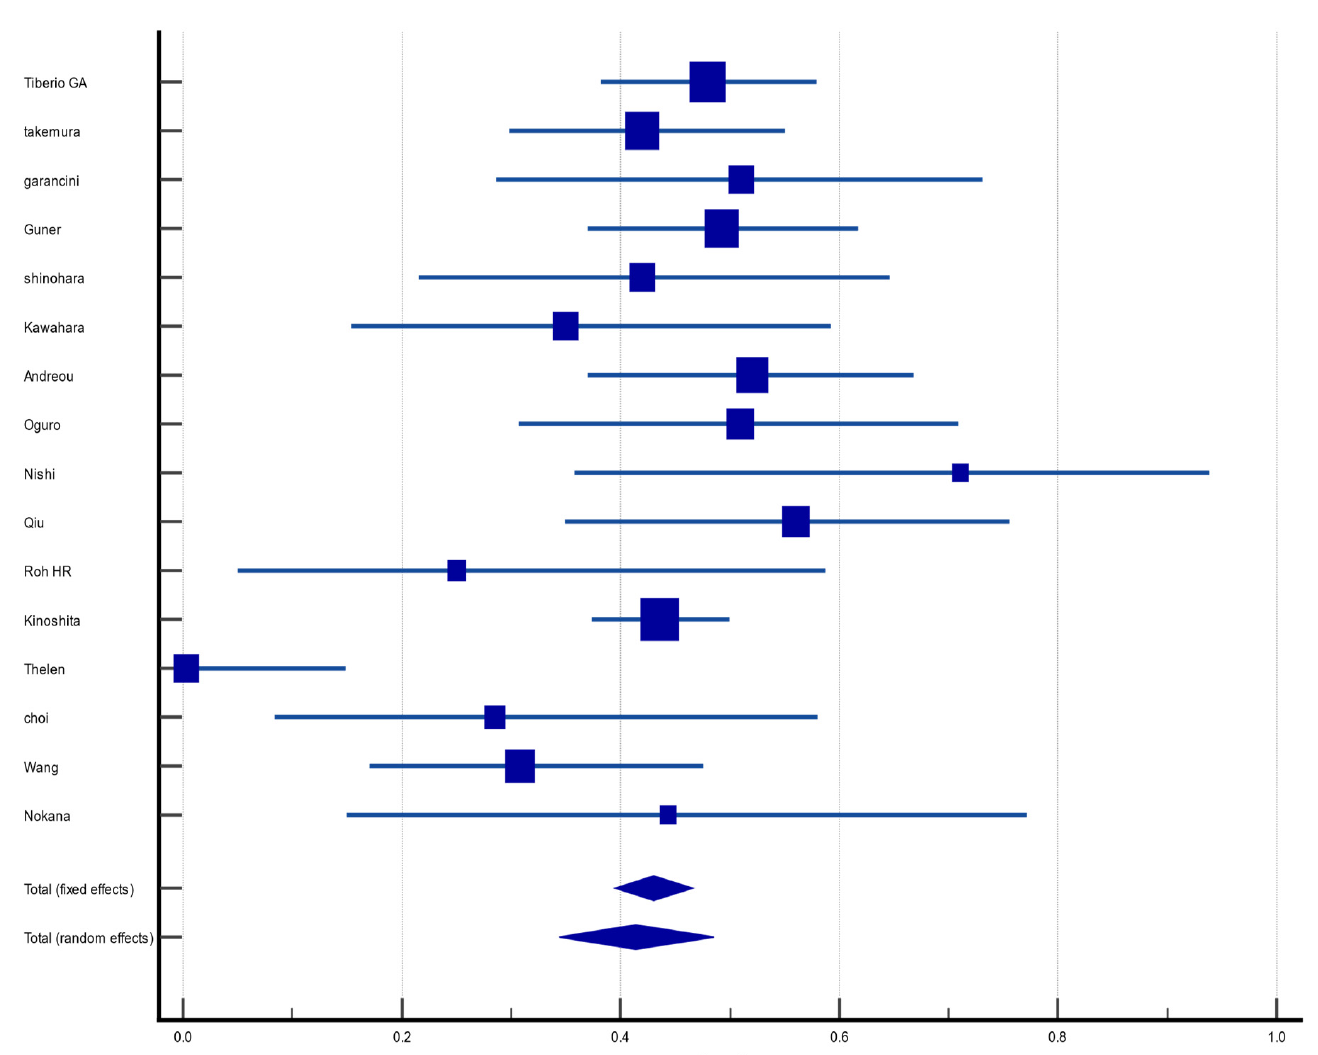
Figure 5. Forest plot of disease-free survival at 1 year after hepatectomy for gastric cancer liver metastasis (GCLM). Description of the proportion and confidence intervals at 95% in the studies that reported 1-year disease-free survival.